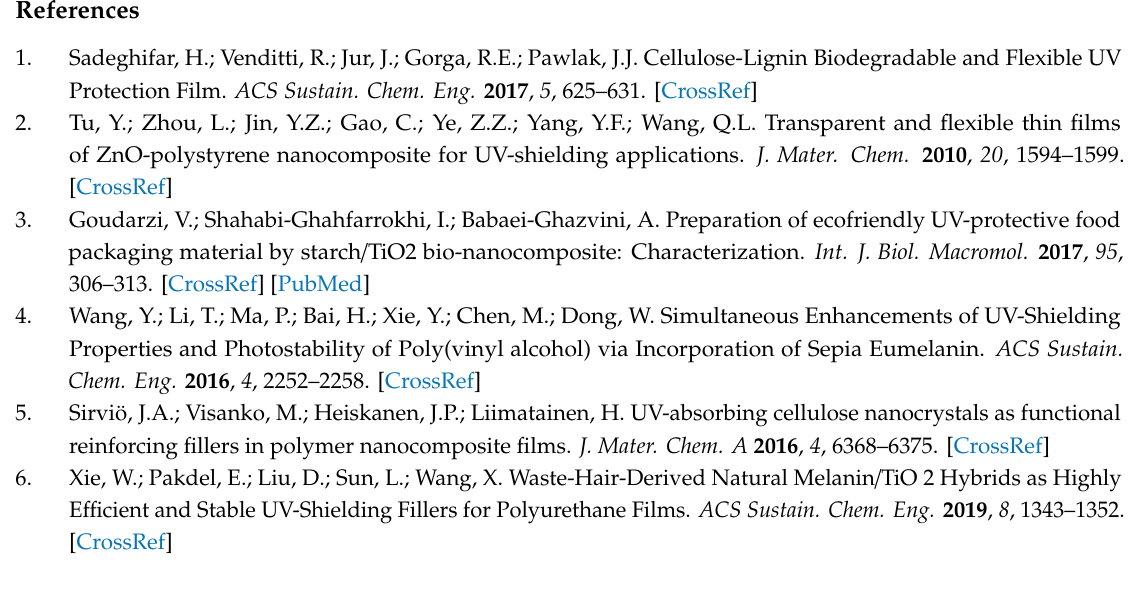
Figure S1: The deconvolution of XRD patterns of pure PVA